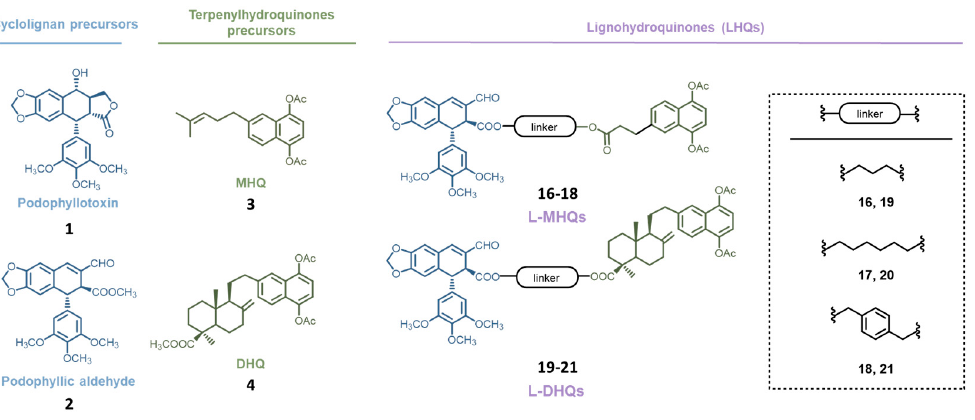
Figure 7. Structures of the precursors and hybrids included in the molecular dynamics and docking calculations.